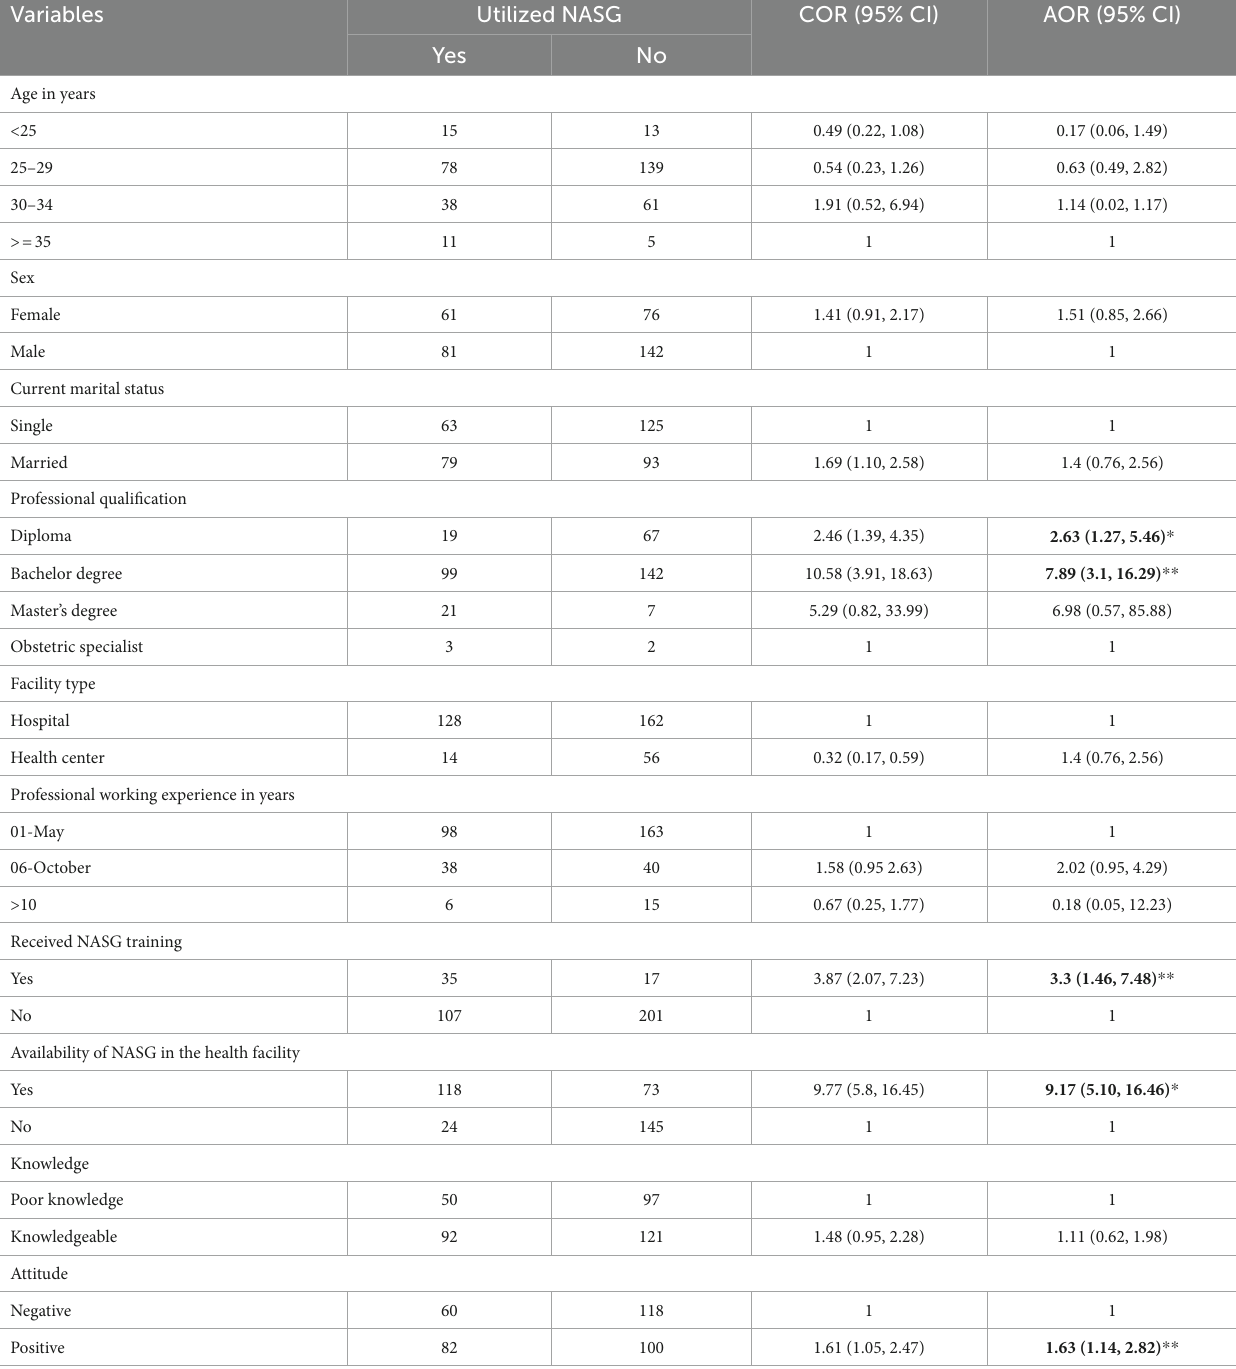
TABLE 3 Logistic regression analysis of factors associated with utilization of NASG for OH management among health care providers in North Shewa zone ( n = 360).